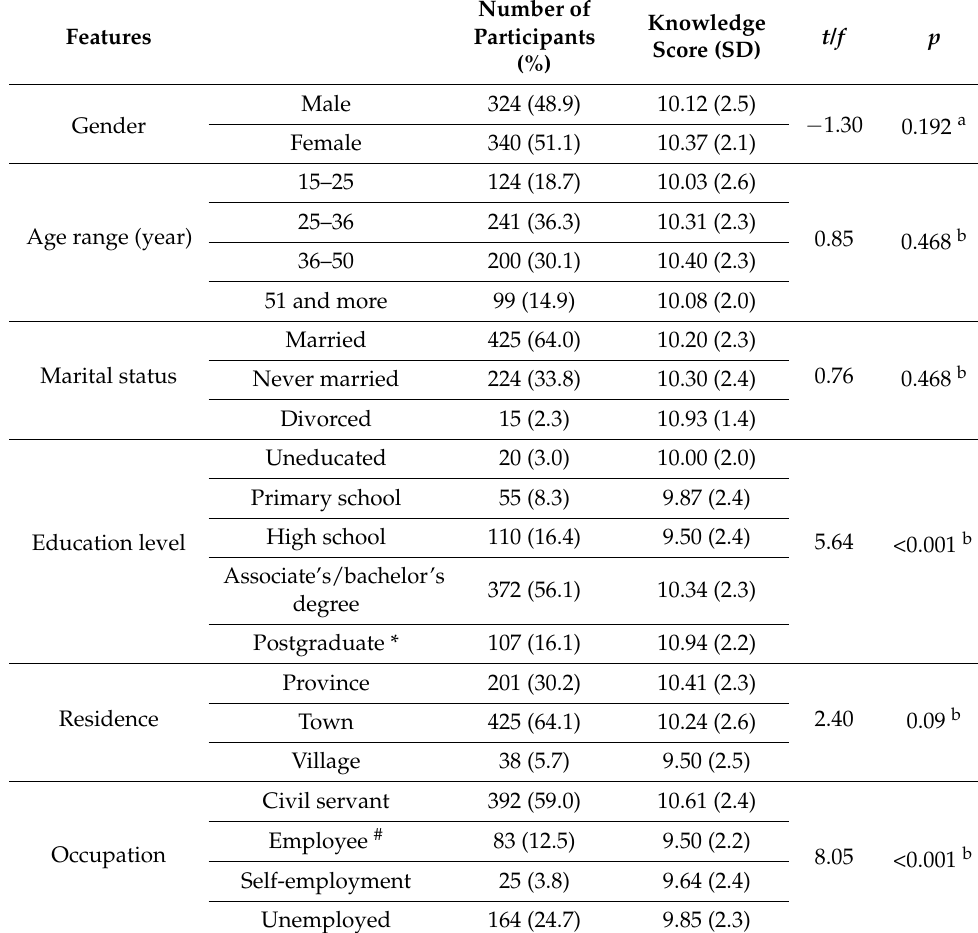
Table 3. The effect of demographic characteristics on the participants’ knowledge scores. ( n = 664).